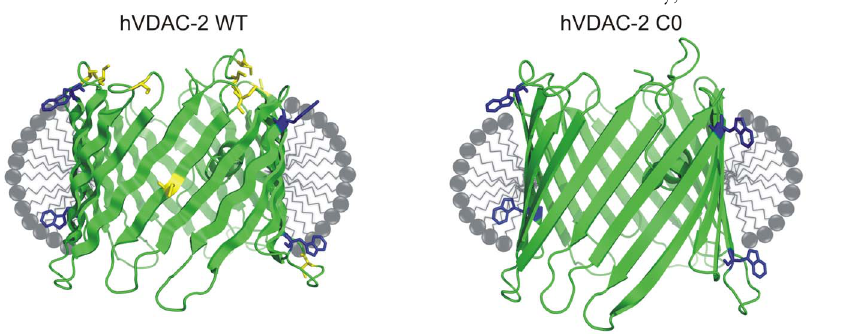
Figure 7. Thermodynamic parameters derived from equilibri- um unfolding measurements of hVDAC-2 in LDAO micelles. (Top) Unfolding cooperativity, which corresponds to the slope of the unfolding transitions shown in Figure 6B, is compared for both WT (black) and C0 (red), in various LDAO concentrations. Note that the values are highest in 13 mM LDAO (corresponding to an LPR of 2600:1) for both refolded WT and C0, and are significantly lowered in high LDAO concentrations. (Bottom) C m values obtained from the fits shown in Figure 6B are compared for hVDAC-2 WT (black) and C0 (red). While C m values for hVDAC-2 WT are comparable between 5 – 65 mM LDAO, C0 exhibits an acute dependence on the LDAO concentration, and is most stable in 13 mM LDAO. Note that the parameters calculated for 80 mM and 100 mM LDAO were derived from linear extrapolation method, since we did not obtain defined pre- and post-transition baselines in these LDAO concentrations. In both the graphs, the sample without LDAO (protein in buffer) is denoted as ‘0 D’ and protein refolded directly in 5 mM LDAO, with LPR of 1000:1, is denoted ‘5 D’. All error bars indicate standard deviation for three independent experi- ments.